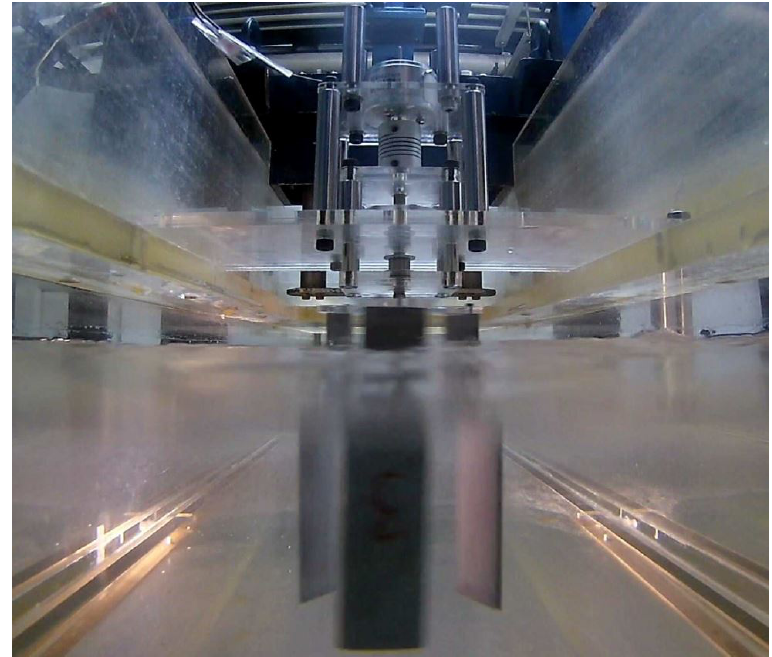
Figure 5. Picture of the single turbine apparatus in the water channel test